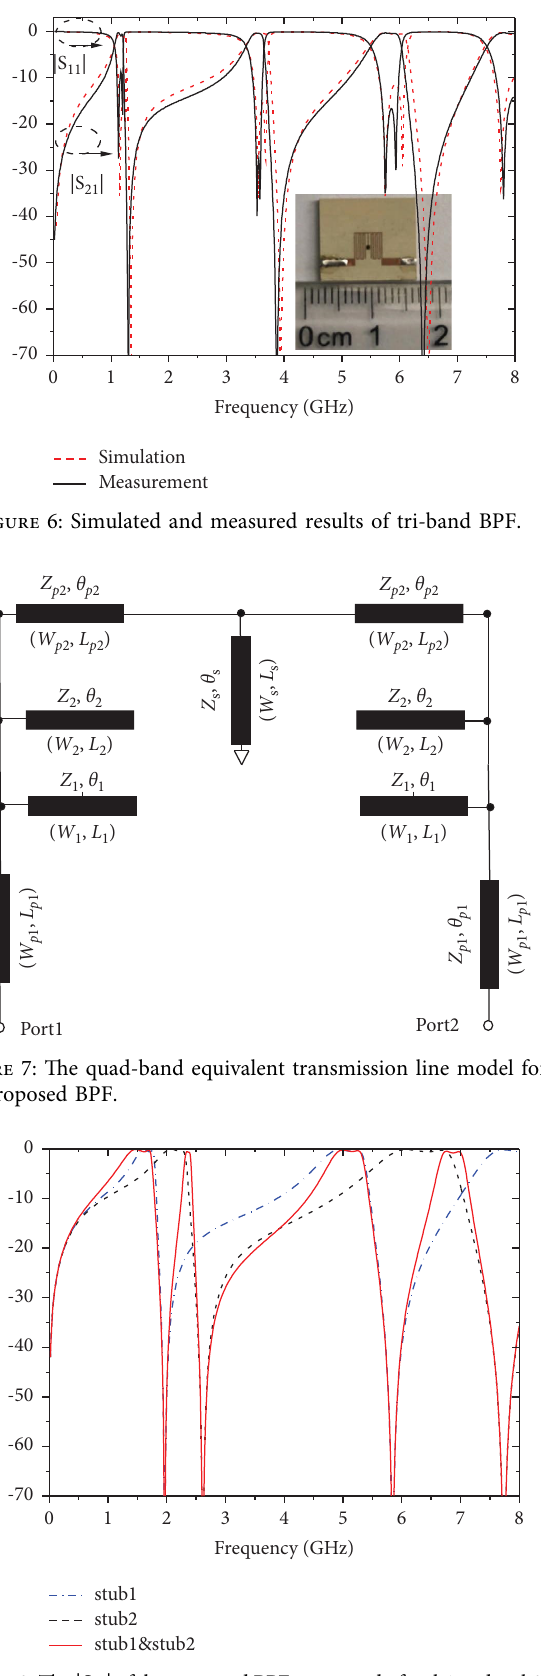
Figure 8: *e | S 11 | of the proposed BPF composed of stub1 and stub2.